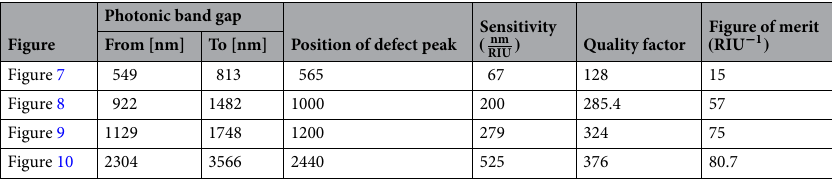
Figure of merit ( RIU − 1 ) From [nm] To [nm]